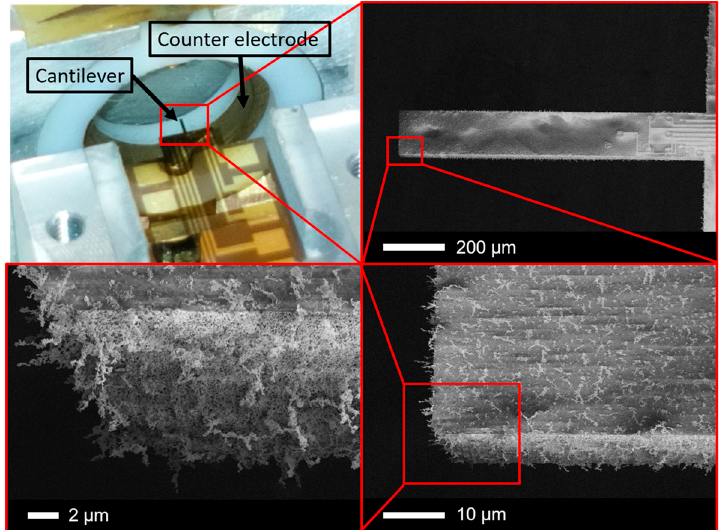
Figure 2. SEM images of a cantilever resonator with electrostatically collected